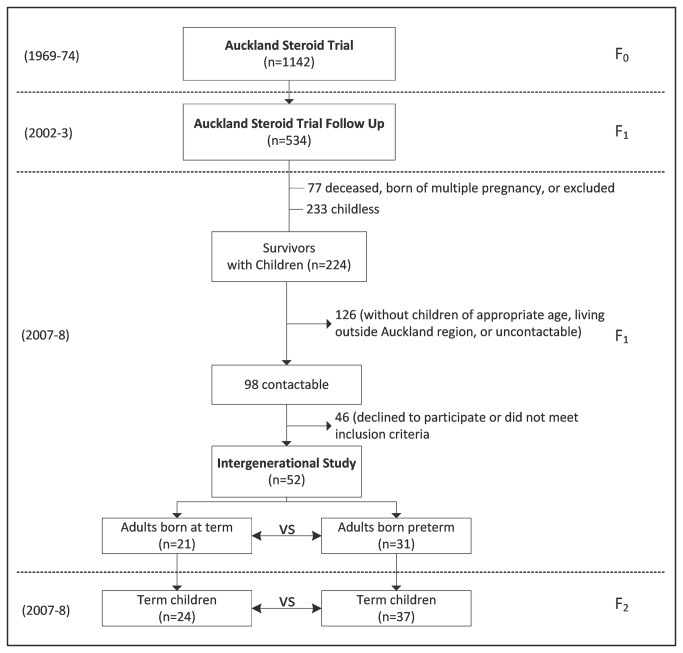
Summary of study's recruitment.